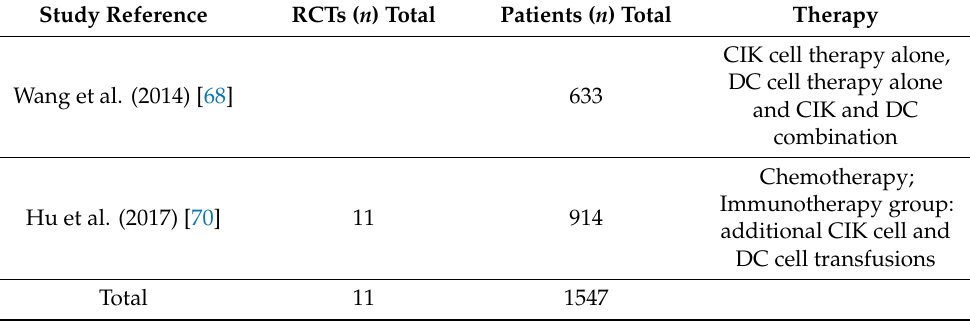
Table 4. Systematic reviews applying CIK cell and DC cell for the treatment of Breast